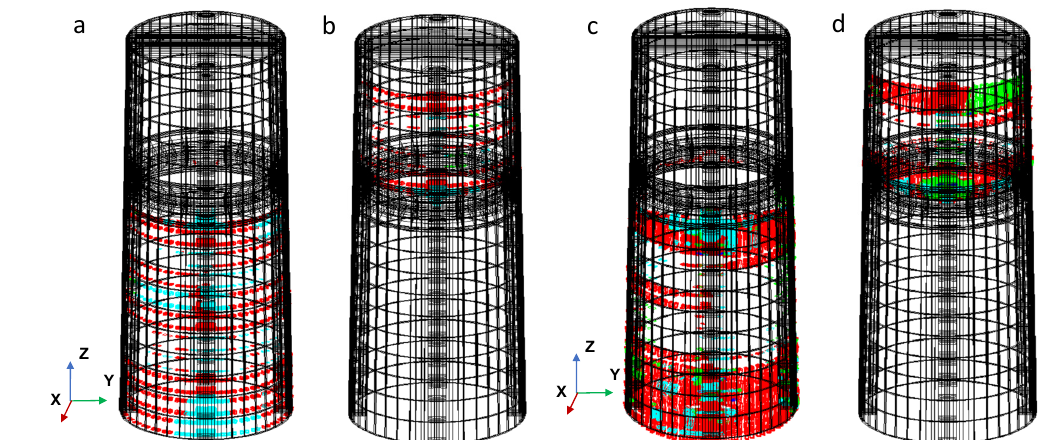
Figure 10. . Crack pattern: (a) Lower ring and (b) Upper ring of ‘t_s1’; (c) Lower ring and (d) Upper ring of ‘t_s4’ (crack status: opening in red colour; closing in green colour, reopening in cyan colour).